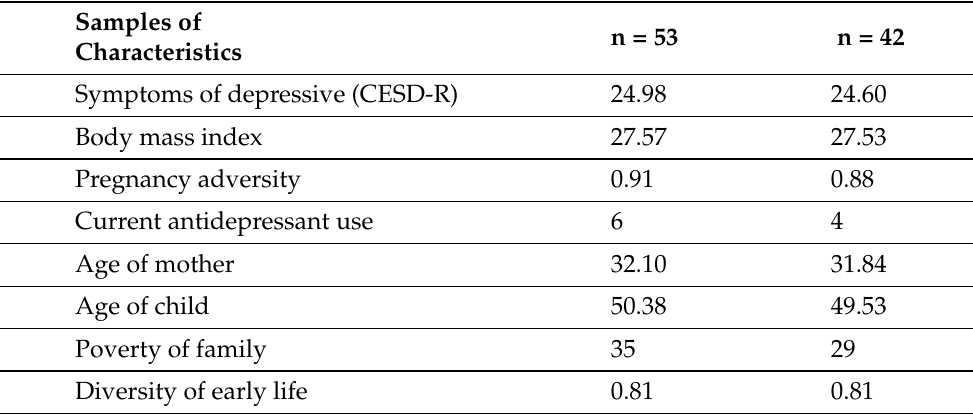
Table 2. Characteristics of the sample’s sociodemographic, adversity exposure, mental health, and physical